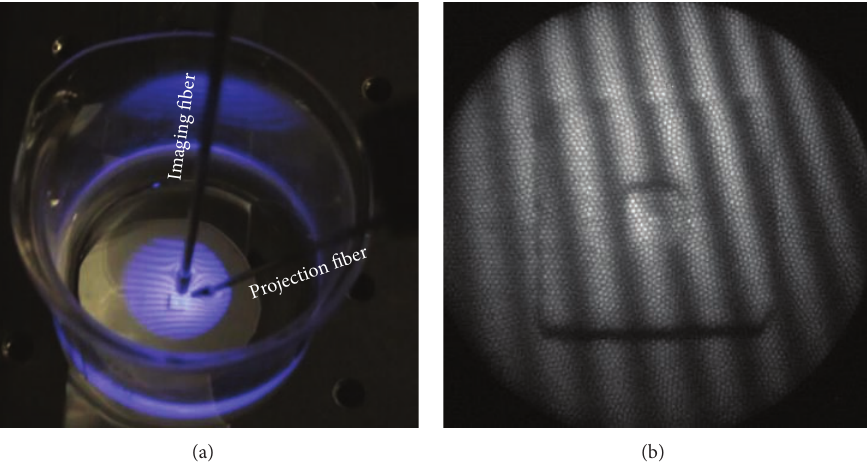
Figure 9: Underwater scenario. Both fibers were dipped in the water. A fringe pattern as seen (a) by an observer and (b) by the camera attached to the rigid fiber scope.